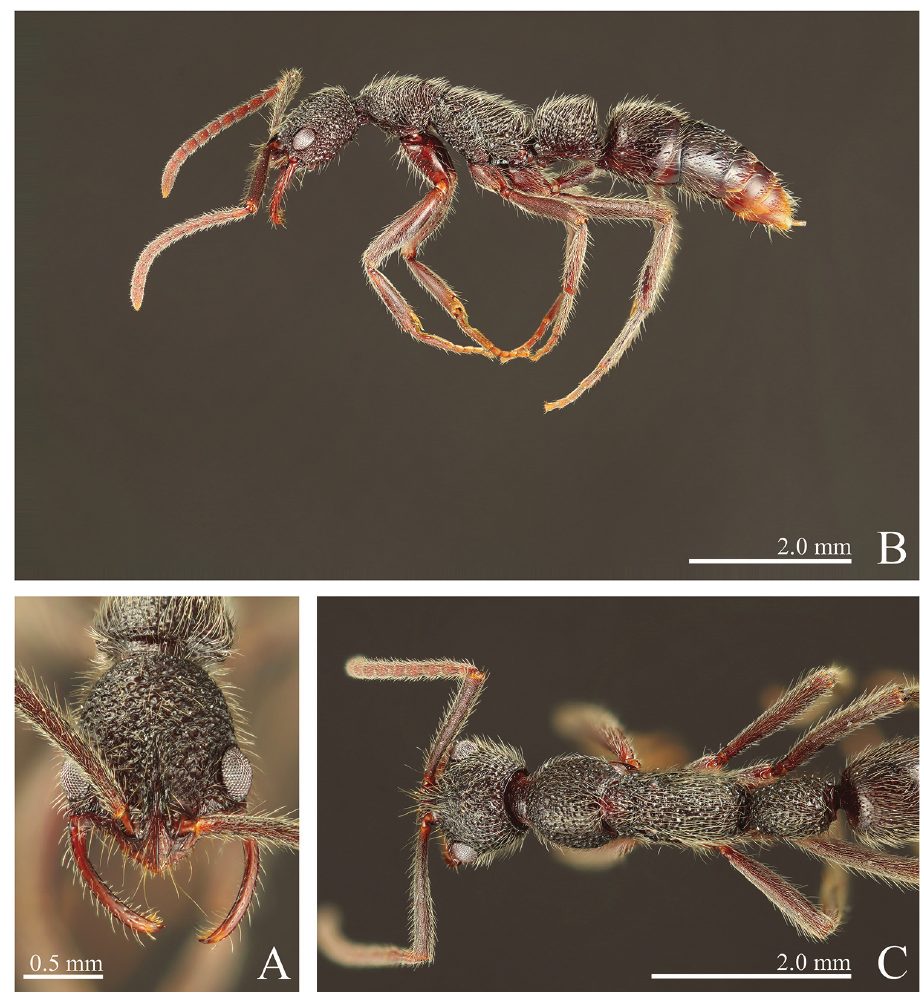
Figure 4. Leptogenys breviloba sp. n., holotype, worker. A head, full-face view B lateral view C dorsal